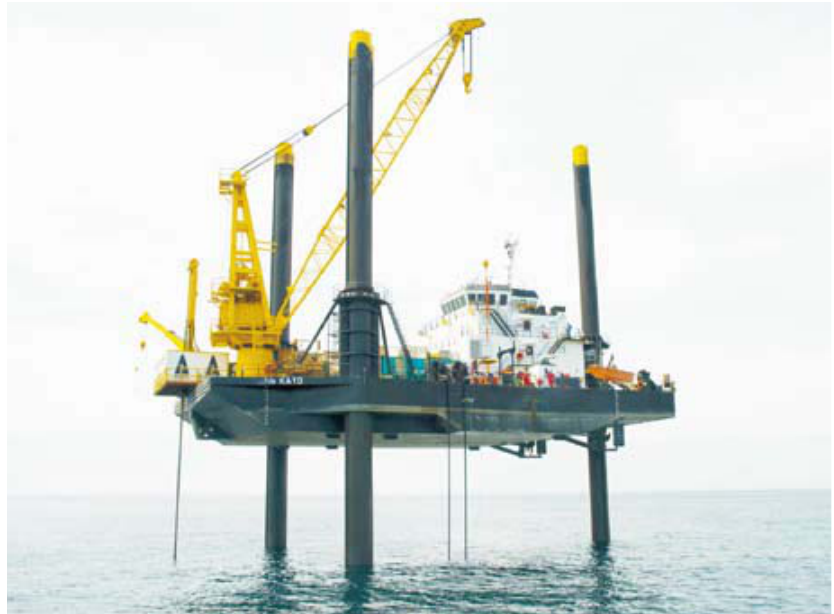
Figure 2. L/B Kayd (Montco Offshore, Inc.) outfitted with a commercial drill rig using coring tools developed and operated by DOSECC, Inc., during Expedition 313 while under direction from ESO. It stands in 35 m of water 45 km off the New Jersey